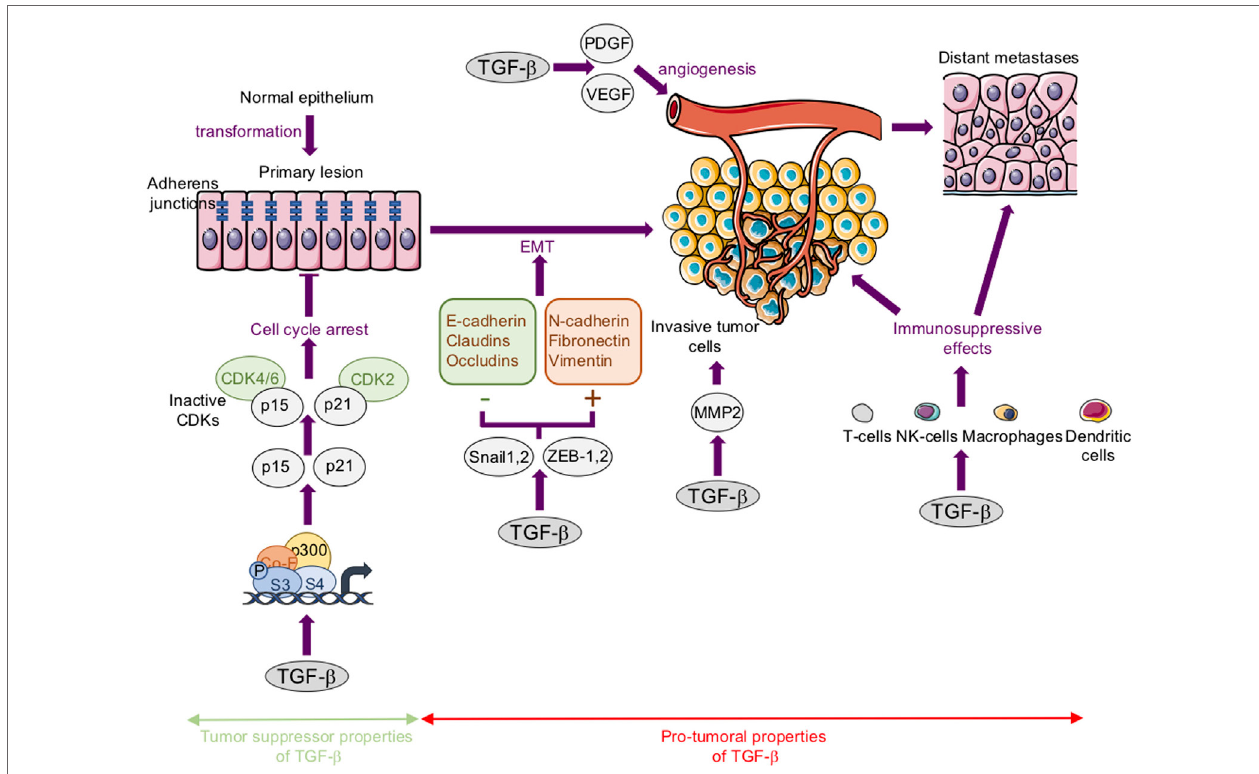
FiGURe 3 | The tumor suppressor and protumoral properties of transforming growth factor- β (TGF- β ) in carcinoma. Tumor suppressor properties : TGF- β s inhibit cell proliferation largely by inducing the expression of cyclin-dependent kinase (CDK) inhibitors such as p21 Cip1 (p21) and p15 lnk4b (p15). Protumoral properties : TGF- β s stimulate epithelial–mesenchymal transition (EMT). This process is associated with a loss or downregulation of E-cadherin, claudins, and occludins, and an upregulation of mesenchymal markers such as N-cadherin, fibronectin, and vimentin. These changes in gene expression are regulated by transcription factors such as Snail-1, Snail-2, ZEB-1, and ZEB-2. TGF- β s stimulate angiogenesis in part by stimulating platelet-derived growth factor (PDGF) and vascular endothelial growth factor (VEGF) expression. TGF- β s favor cancer cell migration and invasion in part by increasing matrix metalloproteinase-2 (MMP) expression. TGF- β s exert immunosuppressive effects via the modulation of the activity or biology of immune cells such as T-cells, natural killer cells (NK-cells), macrophages, and dendritic